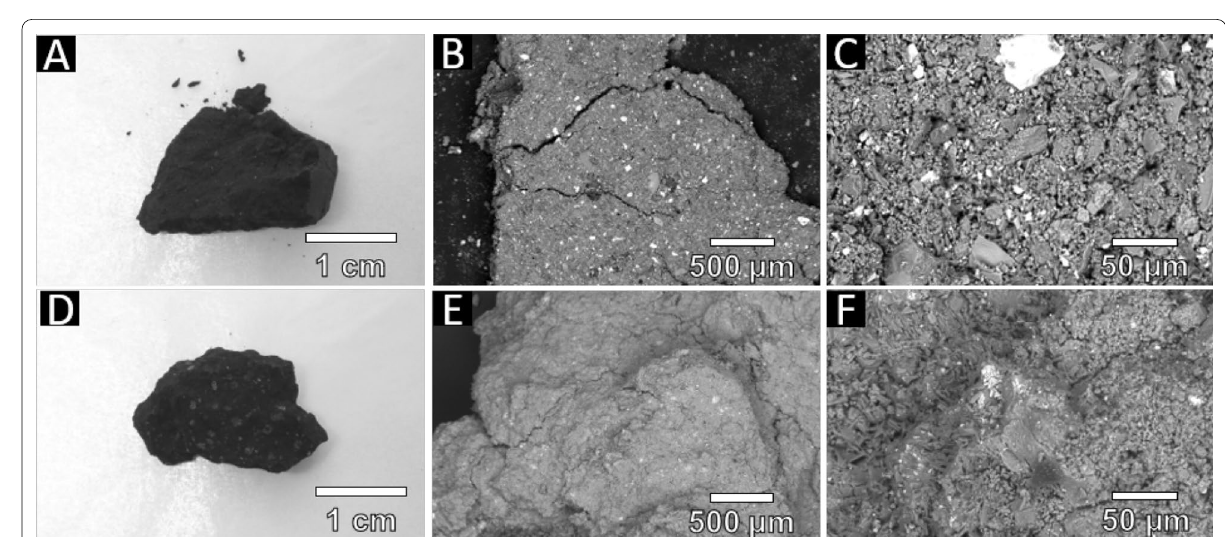
Fig. 5 Optical and backscattered electron images of UTPS‑TB ( A – C ) simulant and Tagish Lake meteorite ( D – F ). UTPS‑TB simulate petrographical signature: phenocrysts of silicate and opaque minerals are embedded in a loosely jammed fine grained (< 20 µm) serpentine matrix. UTPS‑TB simulates mineral abundance and visible and near‑infrared reflectance of Tagish Lake